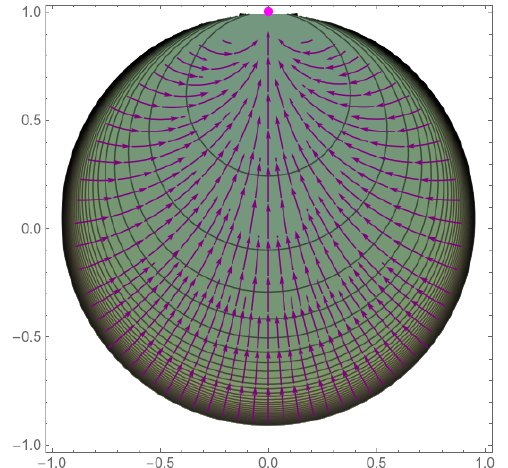
Figure 4. Contour plot of (cid:3) 1 ; 0 ; 1 (non-degenerate lightlike case with (cid:1) = 1), where the gradient (cid:13)ow of (cid:3) is indicated by purple arrows. The values of (cid:3) decrease from lightest brown to darkest green. The point where (cid:3) tends to zero on the conformal boundary of the hyperbolic disk is shown in magenta. In this case, the level sets are horocycles centered at this ideal point.